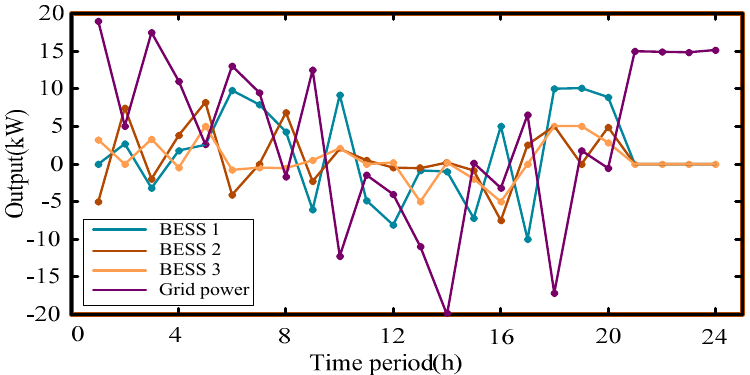
Figure 13. TOU price. Table 8. Parameters of multi-BESSs. BESS Table 9. The operation process in the Experiment 2.